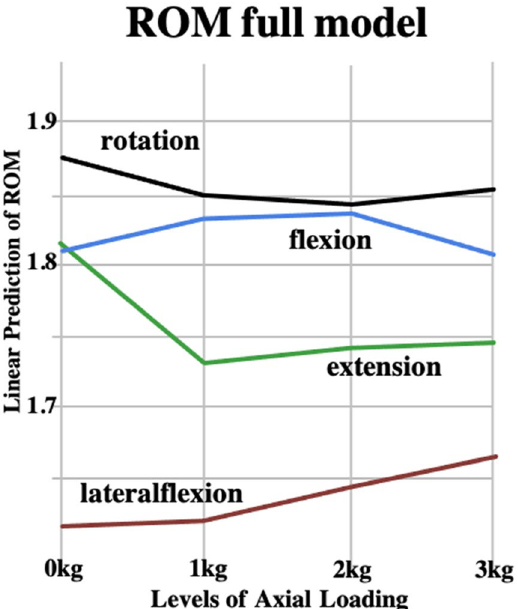
Figure 1. Linear prediction of the C-ROM full multiplicative model with